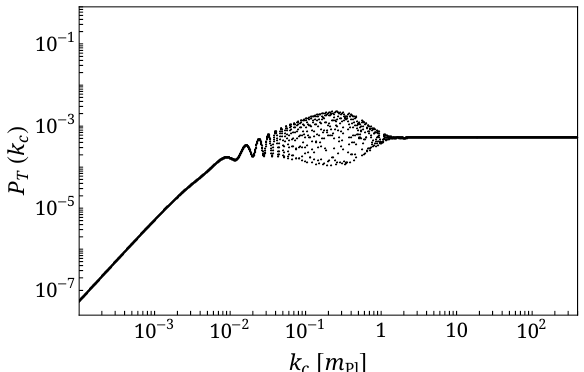
Figure 4. Primordial tensor power spectrum obtained from the scale factor evolution with one bounce characterized by C = 1, µ = − 400, σ = 2, and B =